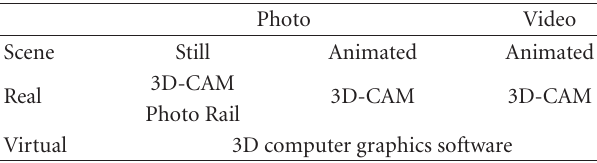
Table 1: Proposed solutions according to the main features of scenes to be